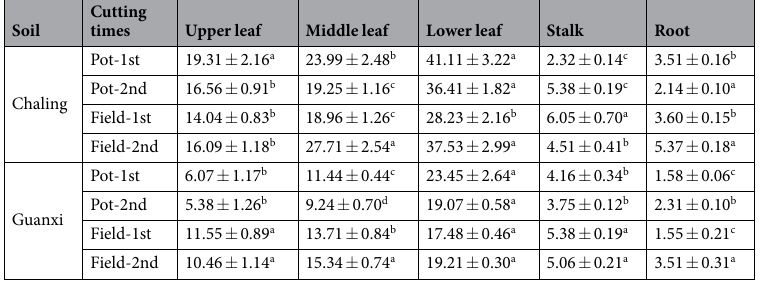
Table 1. BCF values for tobacco grown in pot and field experiments. Note: Standard deviation is represented here as ± SE (n = 3); columns with different letters indicate a significant difference at the P ≤ 0.05 level on the basis of Duncan’s multiple range test.